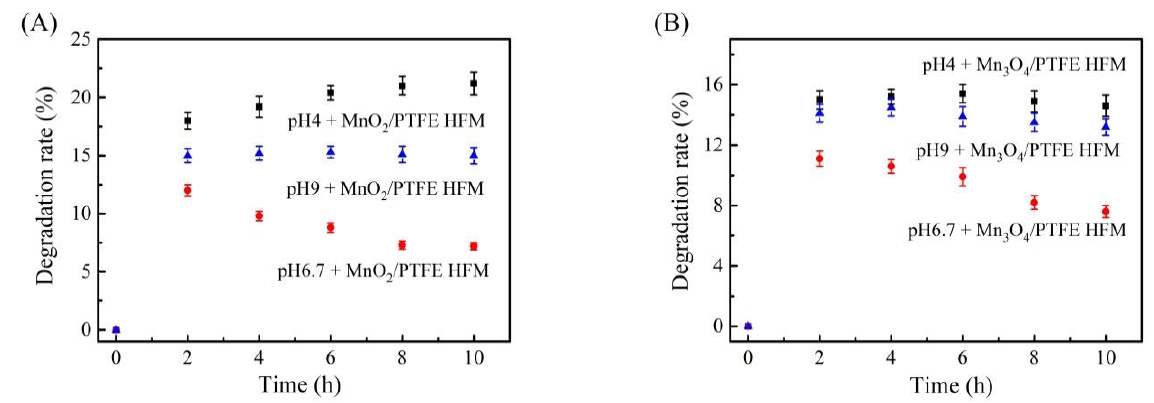
Figure 11. The influence of pH on the degradation of phenol: ( A ) MnO 2 /PTFE HFM ( B ) Mn 3 O 4 /PTFE HFM.